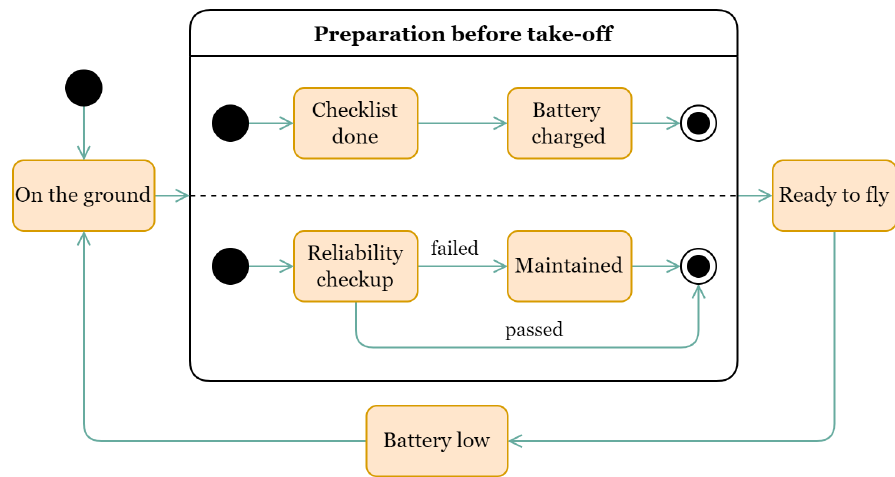
Figure 1. A statechart diagram of the monitoring